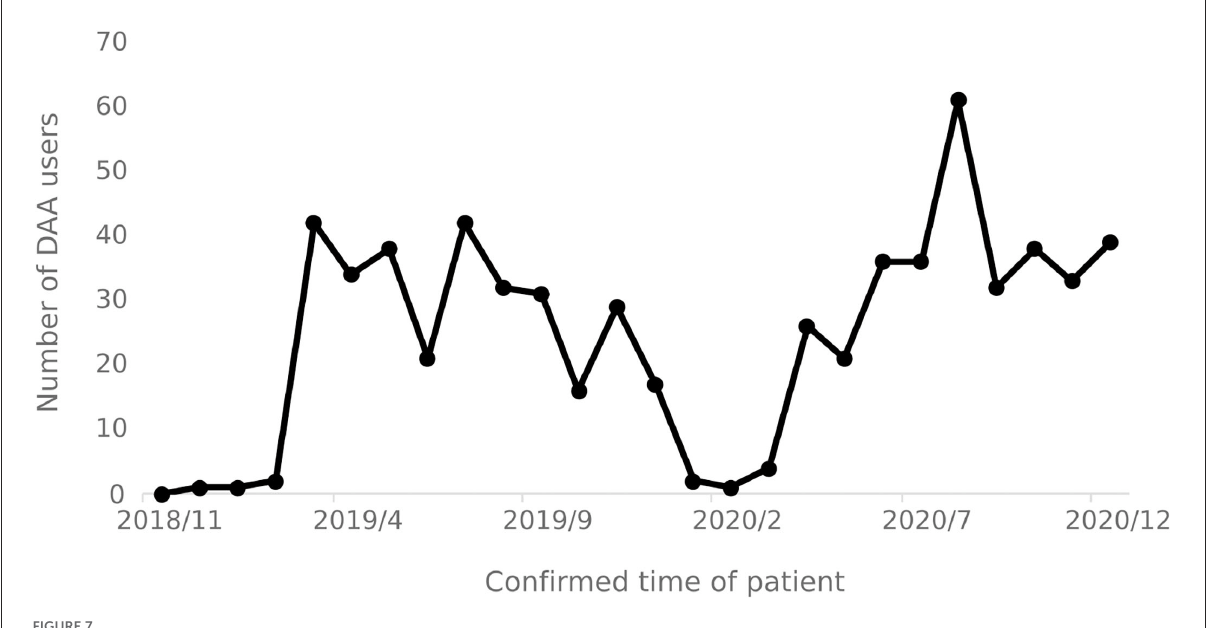
FIGURE7 Users of DAA drugs per